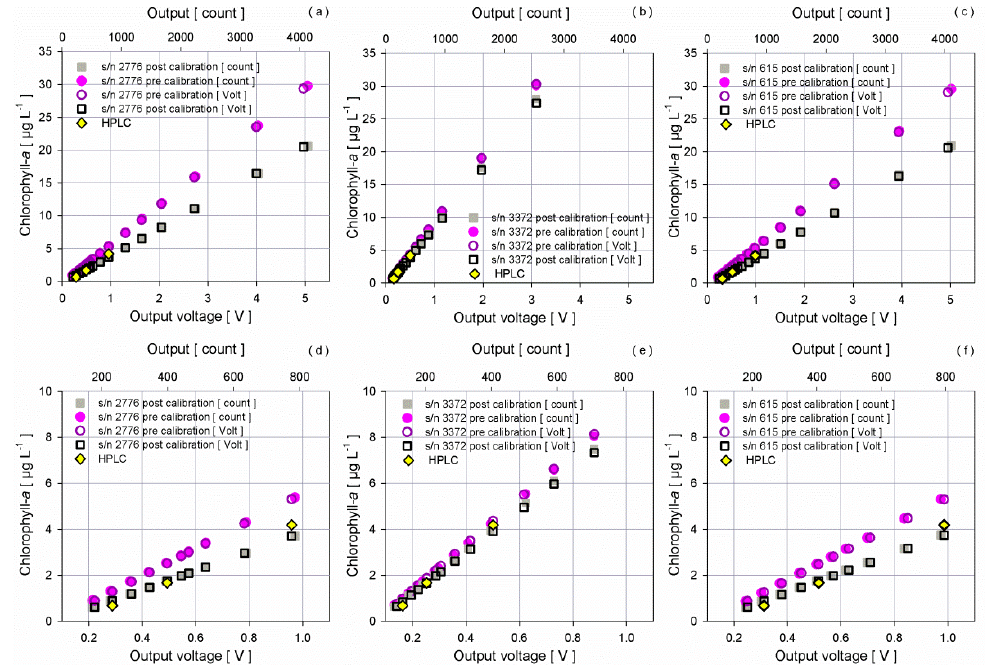
Figure 11. Dispersion diagrams of chlorophyll- a concentrations and output of the fluorometers in voltage (empty marker) and count (full marker) before (circle) and after (square) the experiment, for fluorometers ( a , d ) s/n 2776, ( b , e ) s/n 3372, ( c , f ) s/n 615. Diamonds correspond to HPLC result. Top diagrams refer to the entire voltage range; bottom diagrams are a zoom in the range 0–1 V.